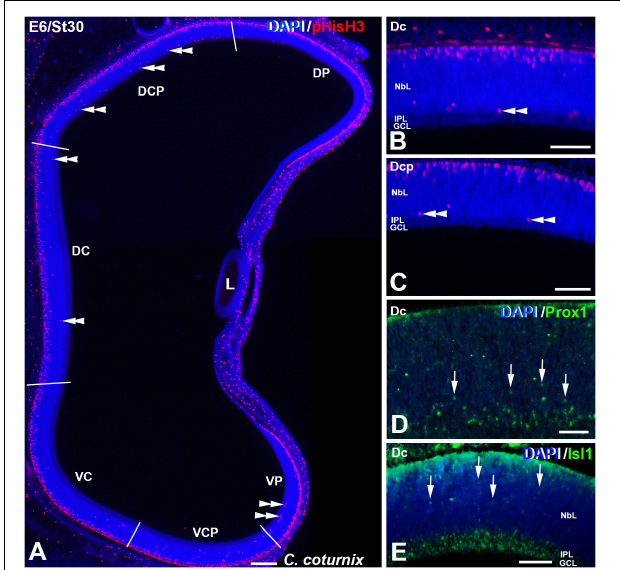
FIGURE 8 | pHisH3 (A–C) , Prox1 (D) and Isl1 (E) immunoexpression in the C. coturnix retina at E6 (St30). Cryosections were counterstained with DAPI. (A–C) Non-apical mitoses were detected in all the sectors analyzed (double arrowheads). (D,E) . Abundant Prox1- (arrowheads in D) and Isl1- (arrowheads in E) immunoreactive nuclei of migrating neuroblasts were found dispersed throughout the NbL. Abbreviations: GCL, ganglion cell layer; IPL, inner plexiform layer; NbL, Neuroblastic layer. Scale bars: 100 µ m in panel (A) ; 50 µ m in panels (B–E) .